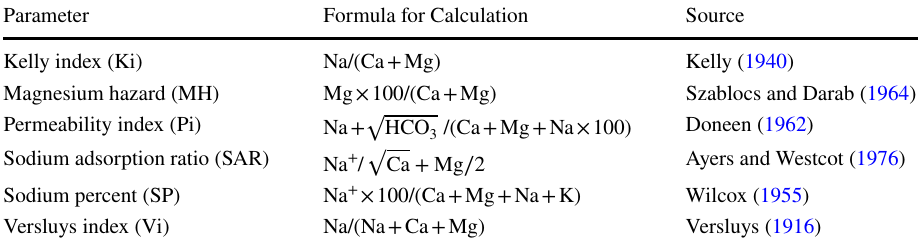
Table 12 Summary of chemical indices used in determining groundwater suitability for